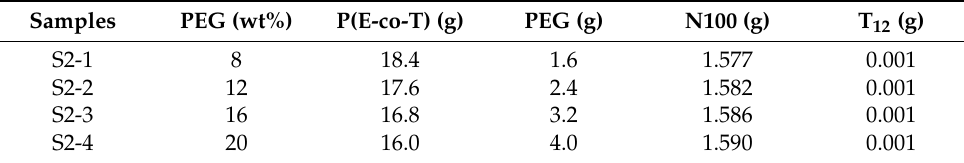
Table 2. Formulation composition of elastomers with different PEG